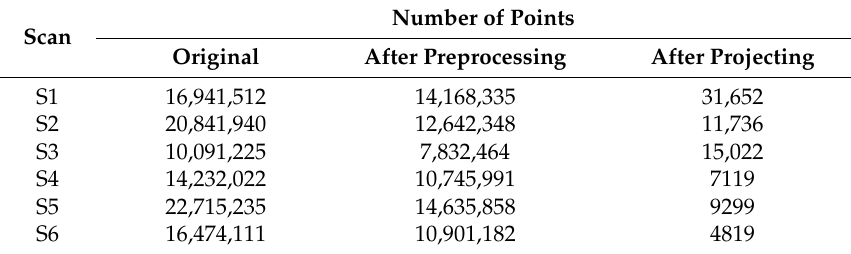
Table 5. Initial distance of each scan pair and the corresponding reference.